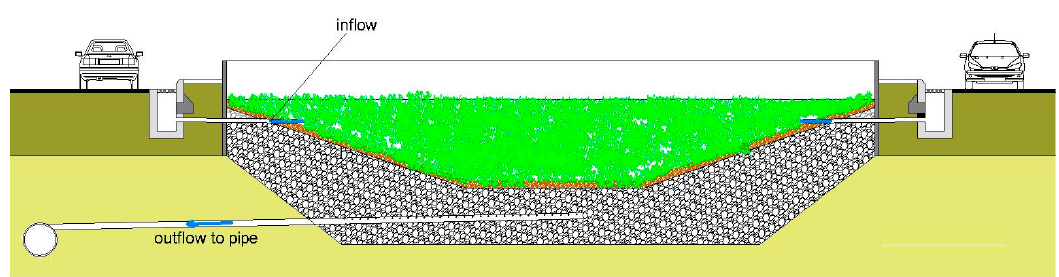
Figure 6. Conceptual sketch of a roundabout detention